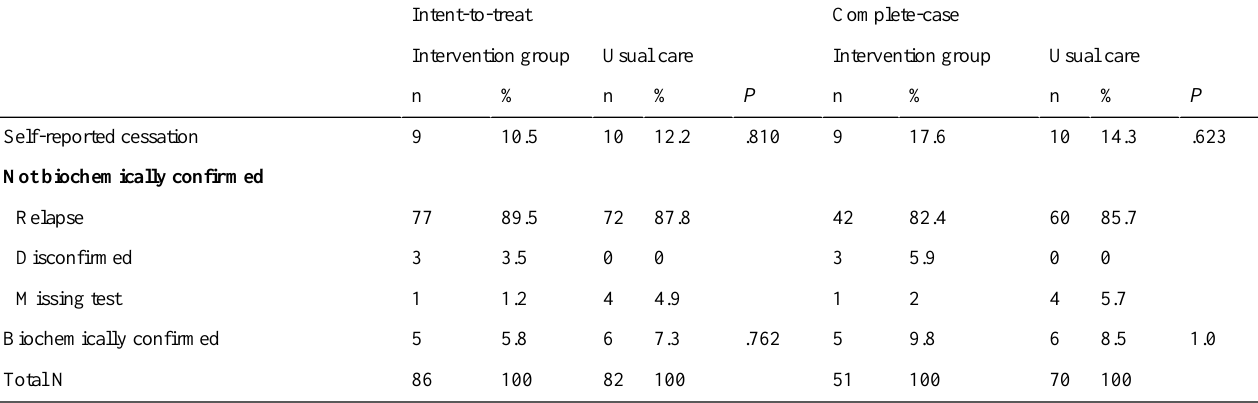
Table 2. Results of self-reported and biochemically confirmed cessation status for intent-to-treat and complete-case analyses ( P values are from Fisher’s exact